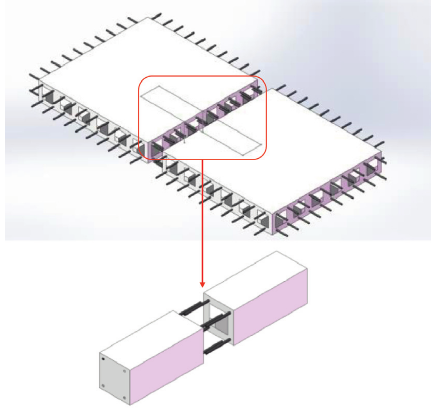
Figure 2: New type of the bridge panels and experimental